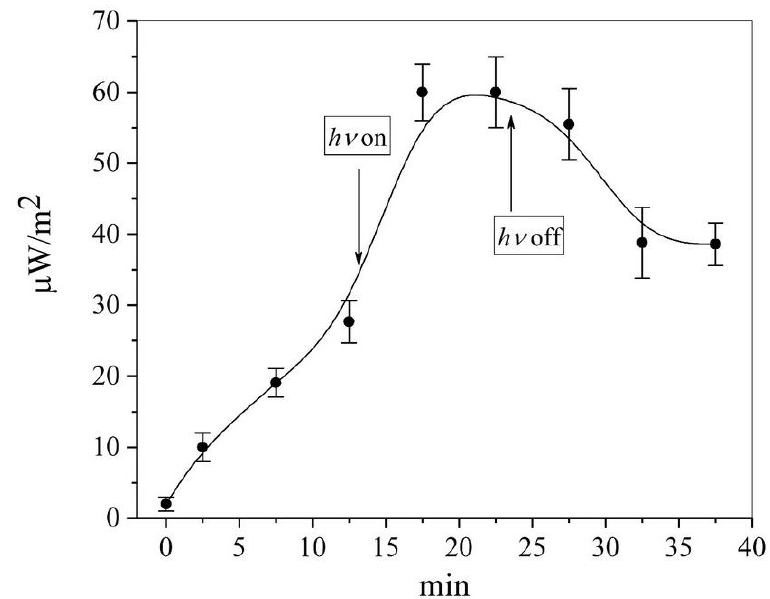
Figure 5. Kinetics of increase and relaxation of the flux density of the thermal radio emission of humic–fulvic nanoparticles. The arrows indicate the light on and off at 412 nm.